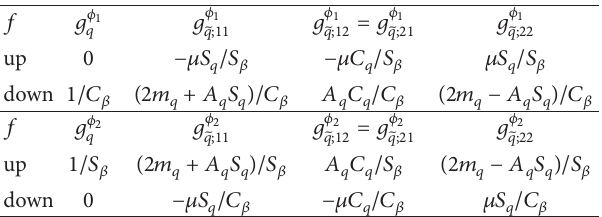
Table 1: Yukawa coupling coefficients for up and down type quark and squark, where 𝑆 𝑞 = sin 2𝜃 𝑞 and 𝐶 𝑞 = cos 2𝜃 𝑞 , and 𝑆 𝛽 = sin 𝛽 and